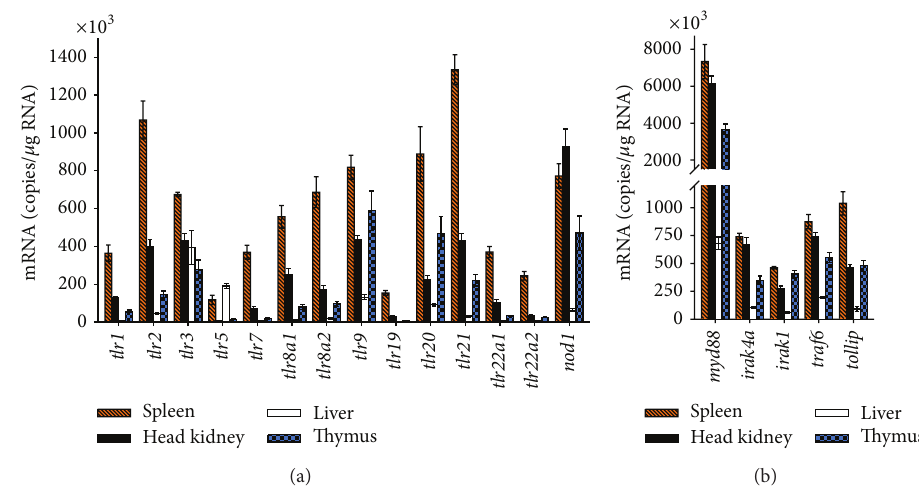
Figure 2: Copy number of (a) PRRs and (b) downstream signaling factors in selected tissues from healthy trout. Quantitative RT-PCR was used to determine the number of transcripts/ 𝜇 g total RNA (ordinate) in spleen (dashed bars), head kidney (filled bars), liver (open bars), and thymus (chequered bars) of five healthy rainbow trout. Bars indicate mean ± SEM.